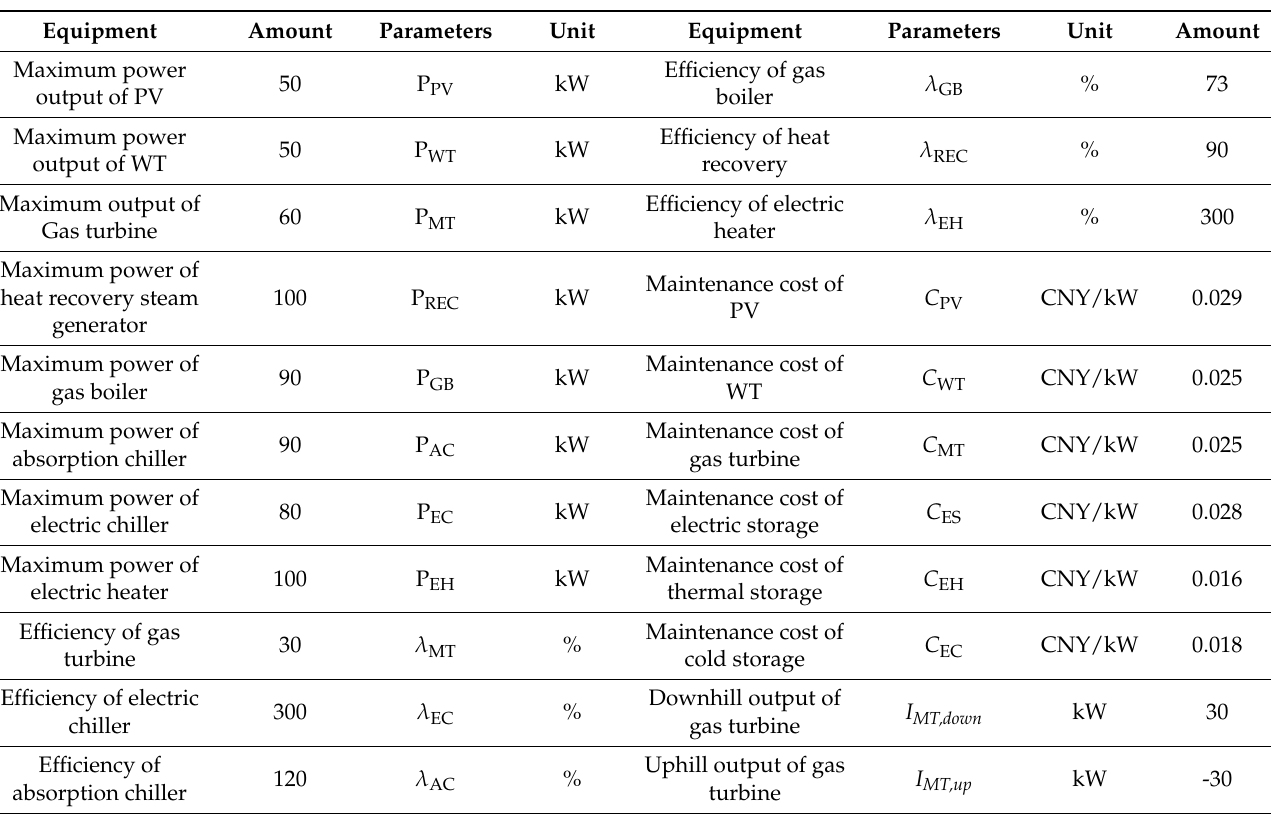
Table 2. Parameters of